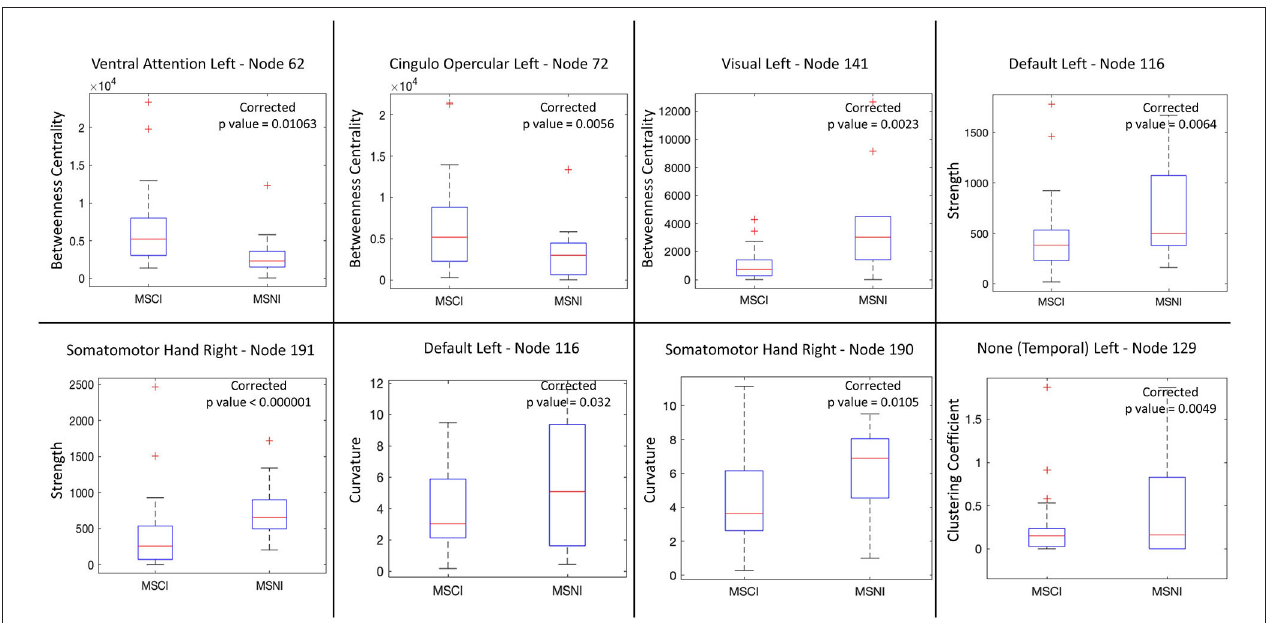
community structure is less pronounced, affecting the temporal lobe functionality and contributing to MS related impairment